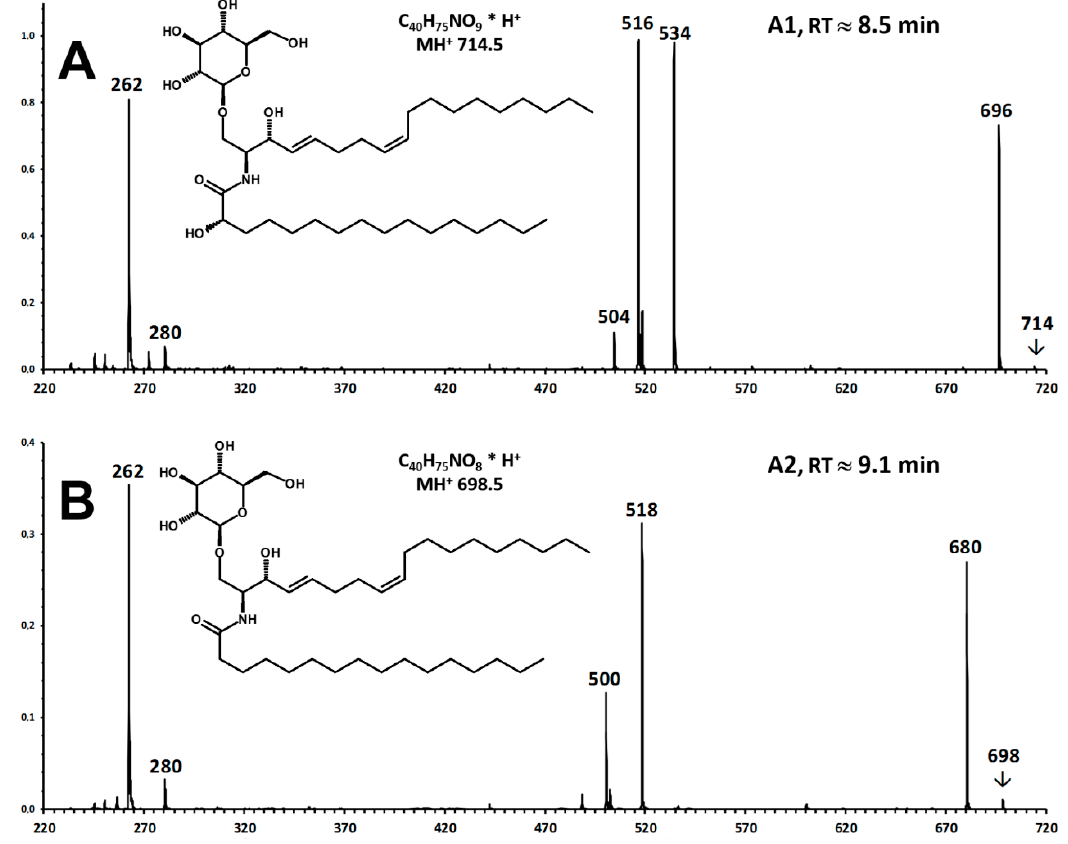
Figure 5. Enhanced Product Ion (EPI, CE 30 DV) spectra of unexpected ceramide species in the extract of a pistachio cultivar. ( A ) Compound A1 is that eluting at 8.5 min in the chromatographic trace A of Figure 1; ( B ) compound A2 is that eluting at 9.1 min.